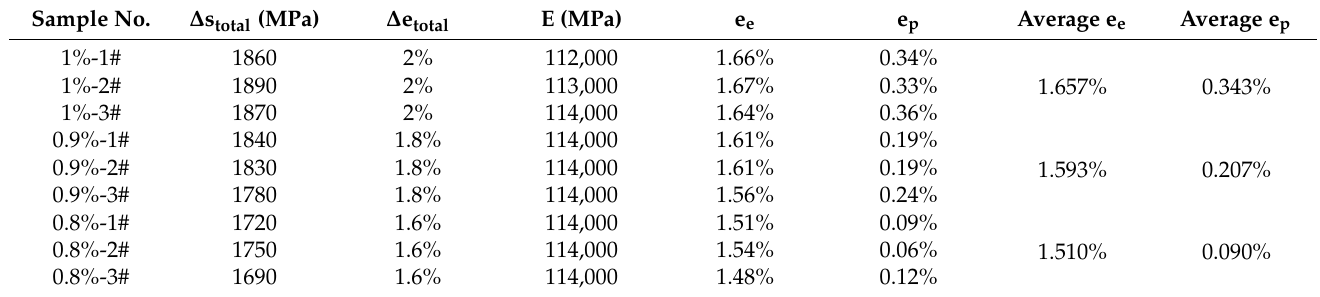
Table 3. Parameters at half-life for LCF test samples at strain amplitudes of 1%, 0.9% and 0.8%.